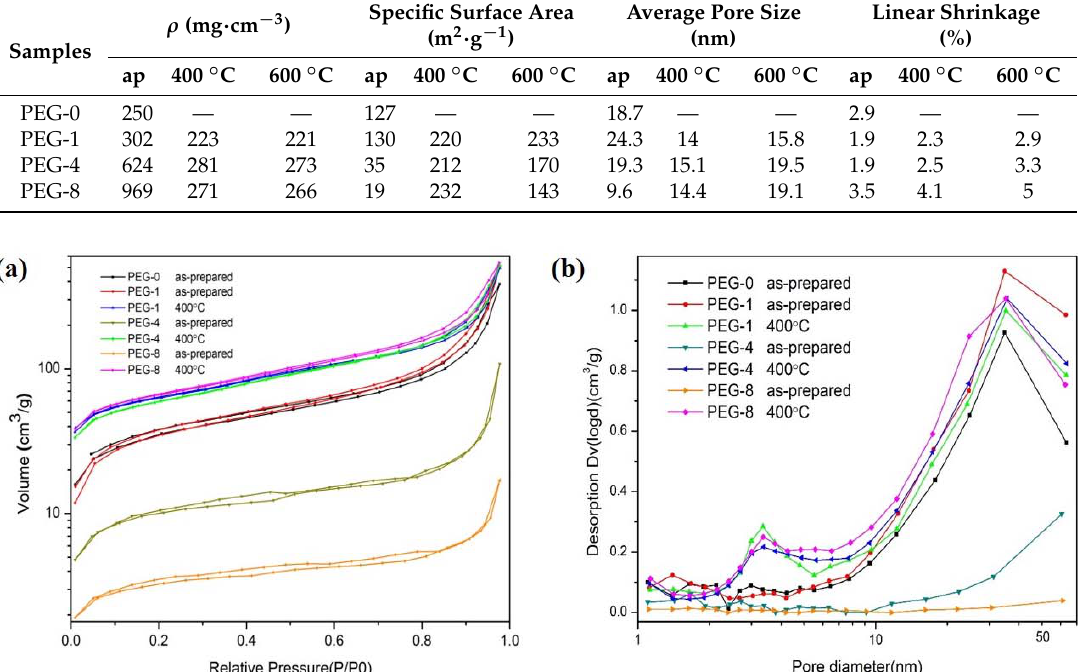
Table 2. Parameters of different silica xerogels. (ap: as-prepared). Samples